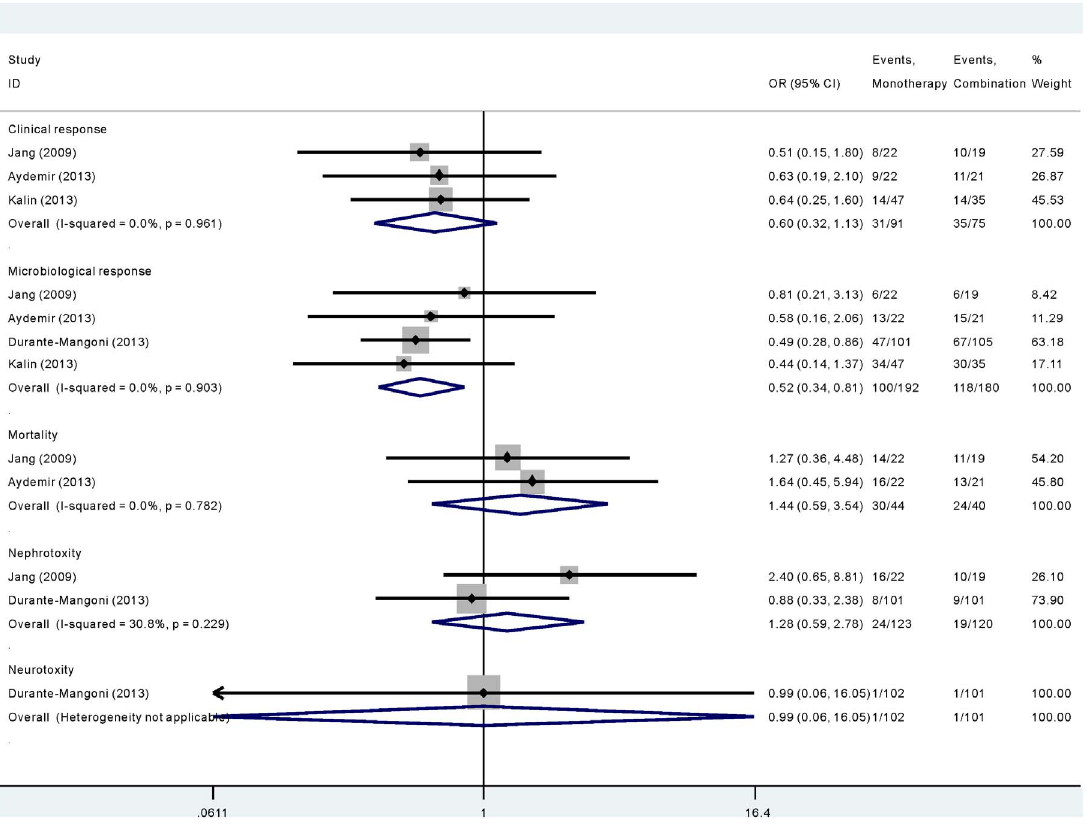
Figure 3. The length of stay in hospital of patients when polymyxins were compared with other antibiotics in Acinectobacter baumannii infection.